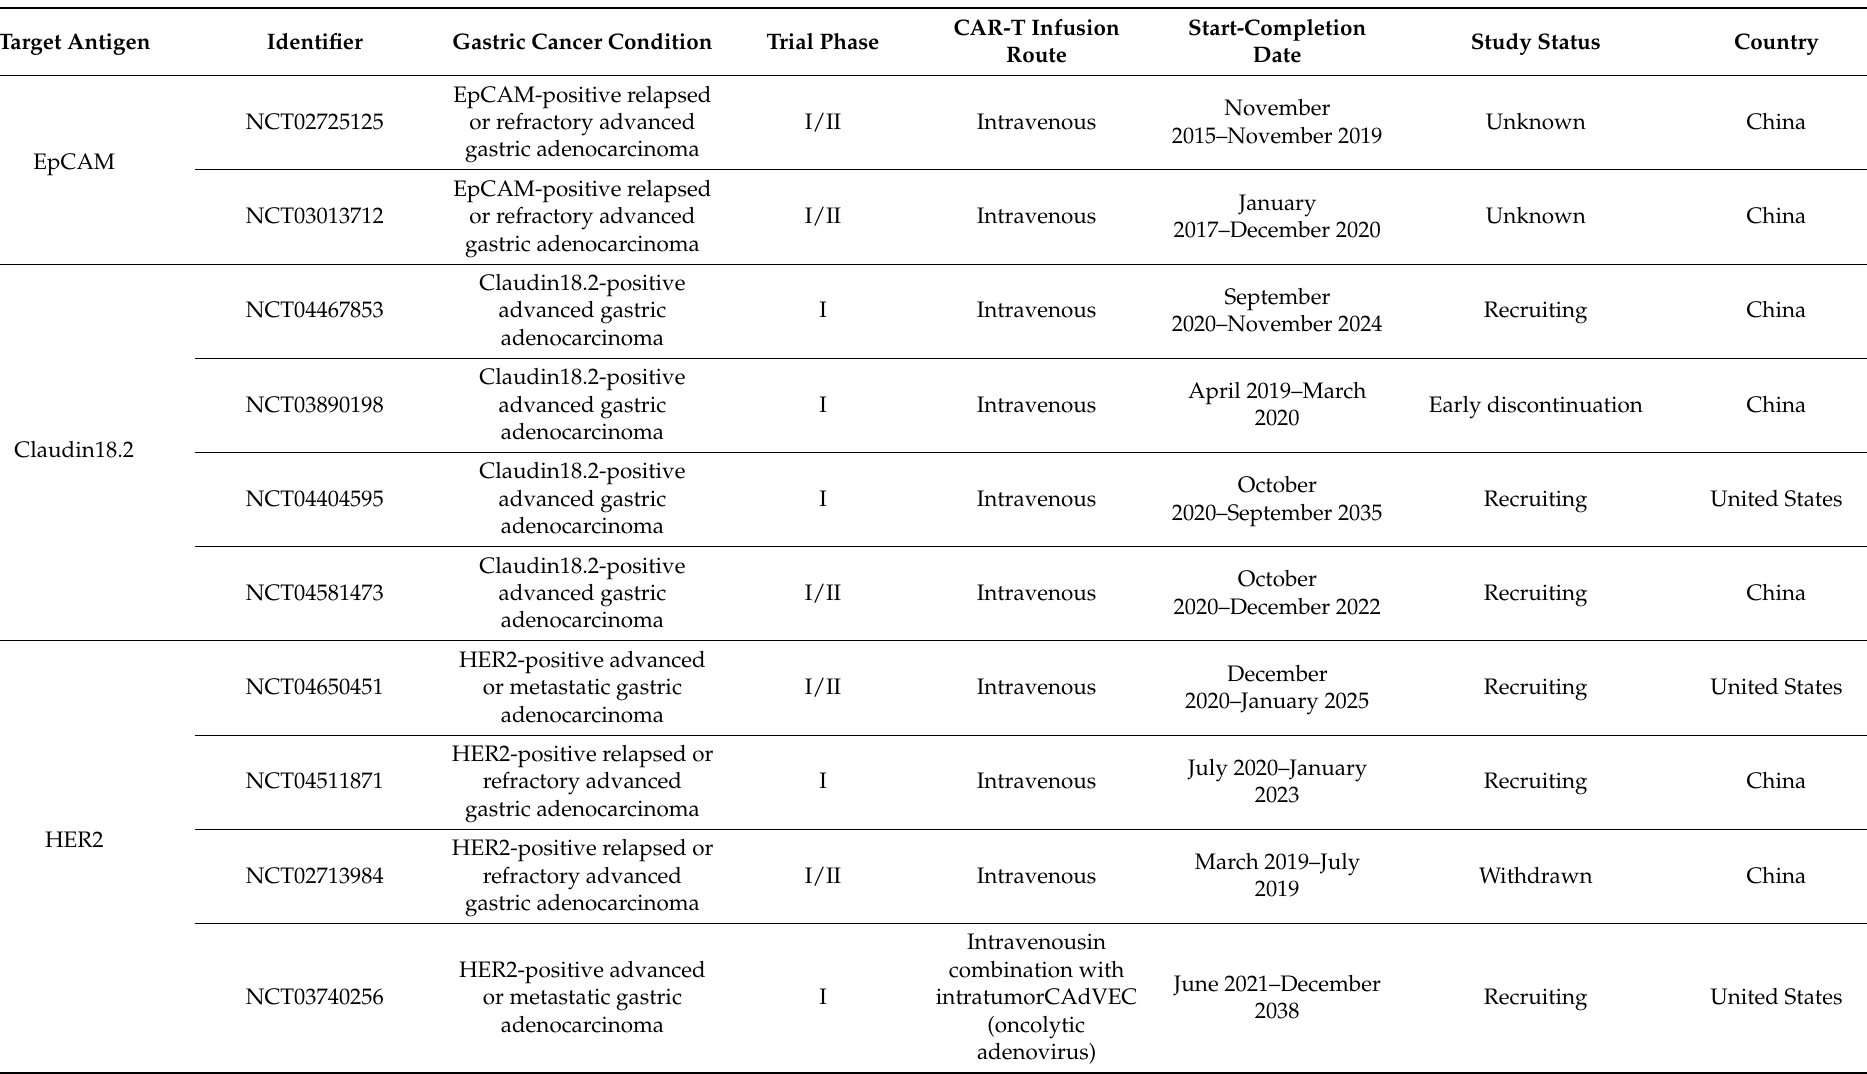
Table 1. Ongoing clinical trials with CAR-T cell therapy in gastric cancer (source: clinicaltrials.gov (accessed on 25 October